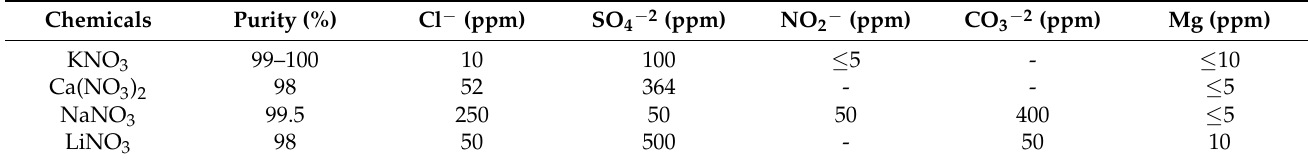
Table 1. Impurities of the raw